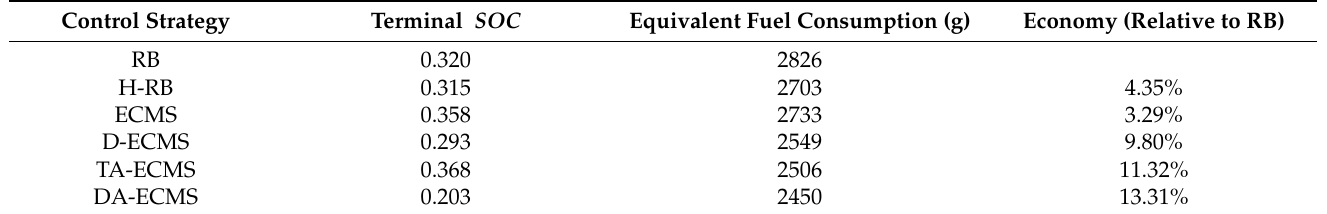
Table 6. Comparison of the simulation results and the data under different energy management